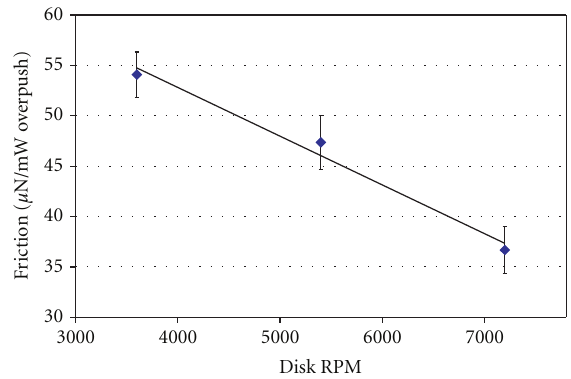
Figure 14: E ff ect of disk RPM on friction for ABS-2. pulse, and the dominant excitation occurs at the slider’s second pitch mode. The pressure under the TFC protrusion at touchdown, the TFC e ffi ciency, and the propensity for lubricant pickup show correlation with touchdown behavior and may be used as metrics for designing sliders with good touchdown features. Experiments are devised to measure the friction at the HDI during TFC-induced contact, and several parametric investigations are carried out. In the range of parameter values considered, the disk surface roughness does not significantly a ff ect the friction during contact. The mobile part of the lubricant plays an important role in reducing friction as well as slider burnishing. A burnished slider shows a higher friction value than an unburnished slider because of an increase in e ff ective/actual contact area, and, for the same reason, sliders with higher TFC e ffi ciency show higher friction compared to sliders with lower TFC e ffi